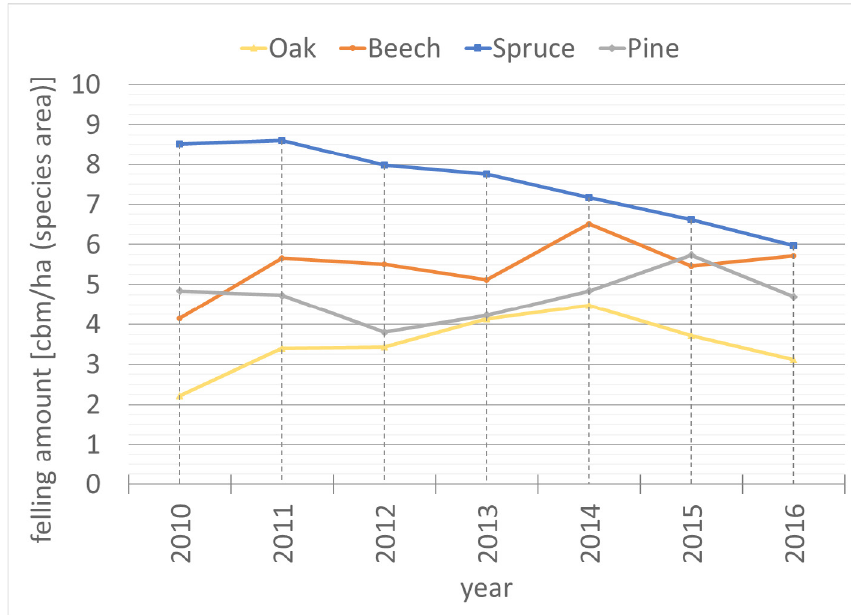
Figure 5: Felling amount per hectare according to main tree